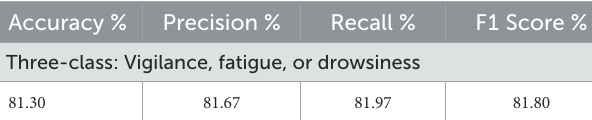
TABLE 8 Four assessment indicators for classifying EEG signals into three states of alertness, fatigue, and